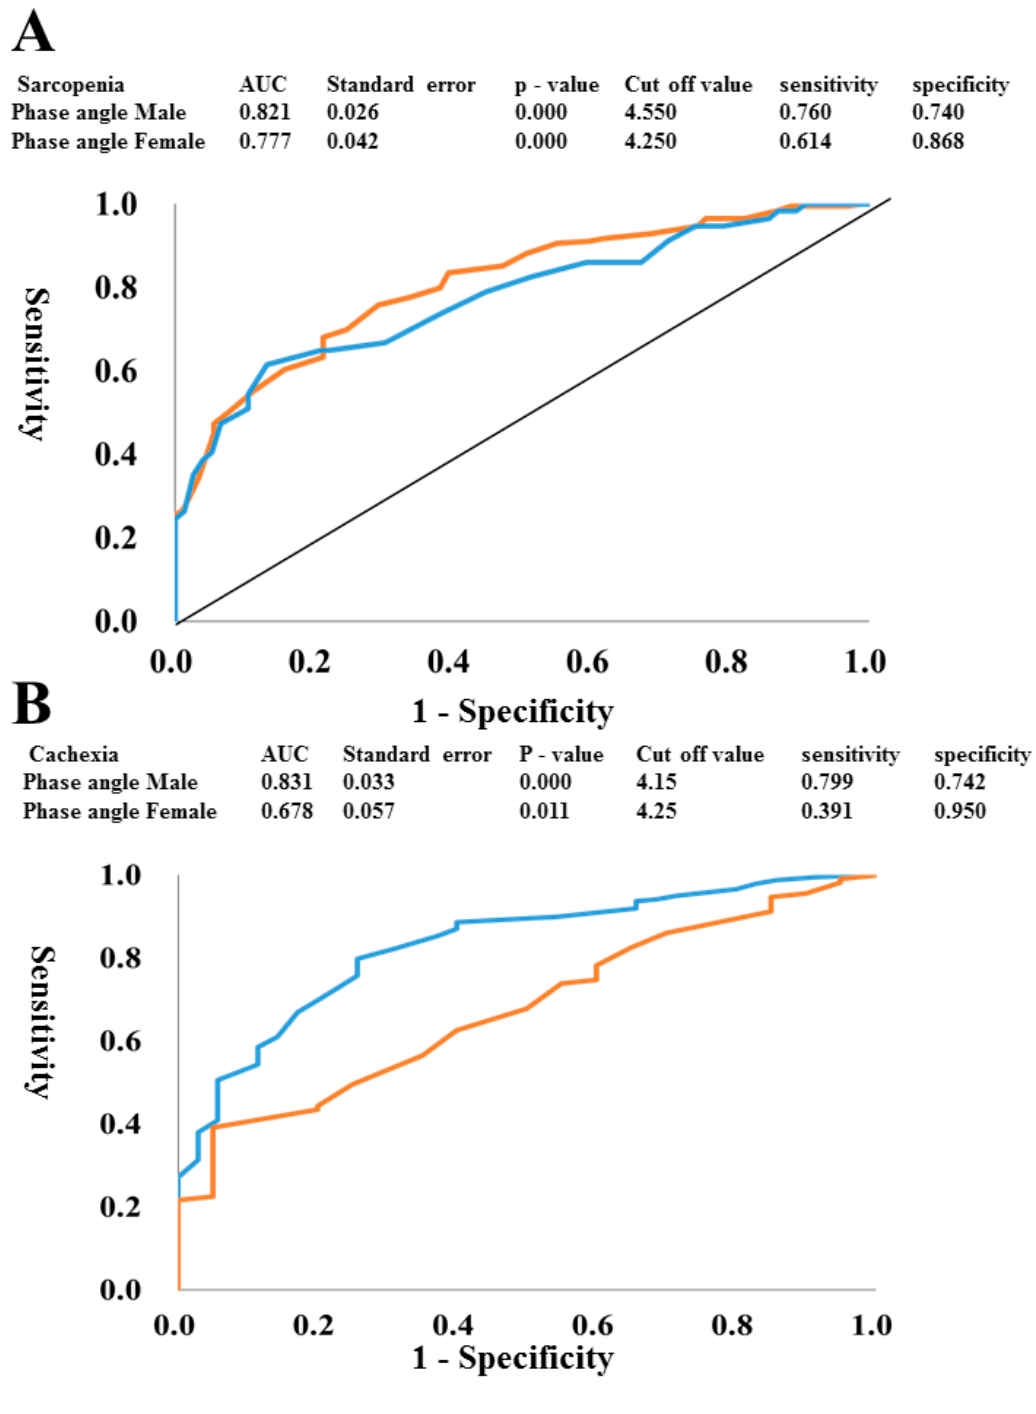
Figure 2. ROC curves to identify the optimal phase angle cut-off for detecting sarcopenia or cachexia. To generate the ROC curves shown, different phase angle cut-offs were used to predict sarcopenia ( A ) and cachexia ( B ) with true positives plotted on the vertical axis (sensitivity) and false positives (1-specificity) plotted on the horizontal axis in both males and females. ( A ) red (male) blue (female) ( B ) blue (male) red (female).